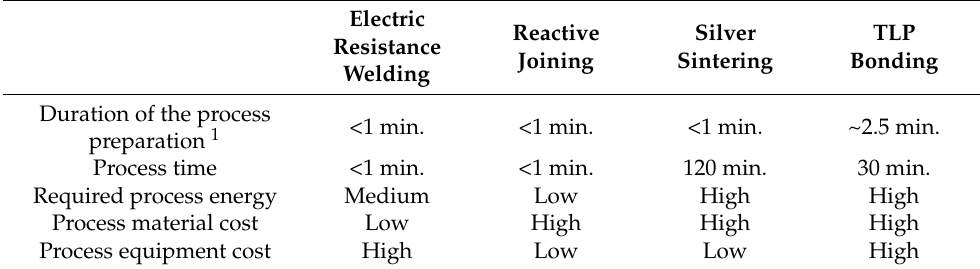
Table 2. Methods used in this work to connect the membrane with the PCB.